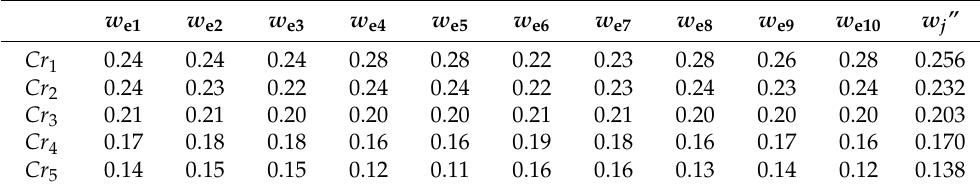
Table 3. Individual and group criteria weights calculated by the SWARA method.